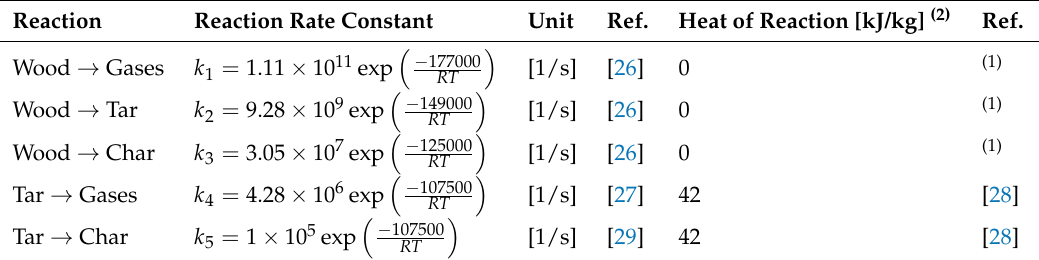
Table 3. Kinetic data used for modeling drying, devolatilization, and char gasification and oxidation. “Gases” in the following table refers to non-condensable